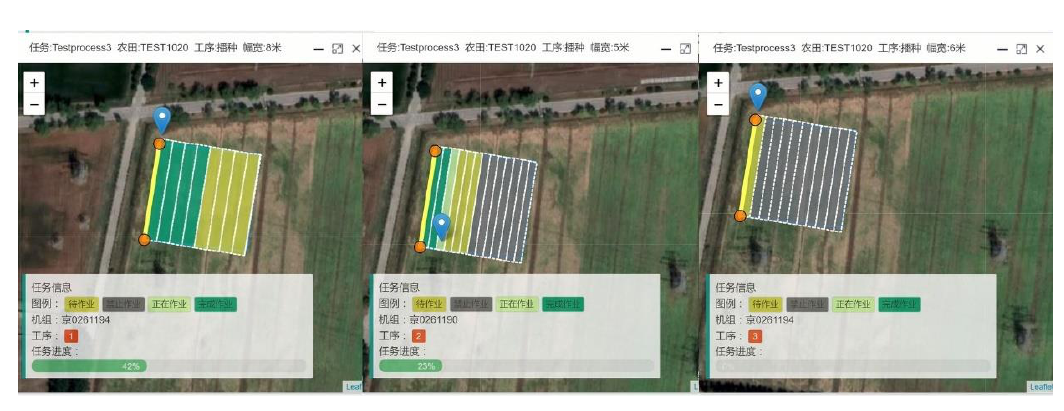
Figure 18. Monitoring interface of ES3.